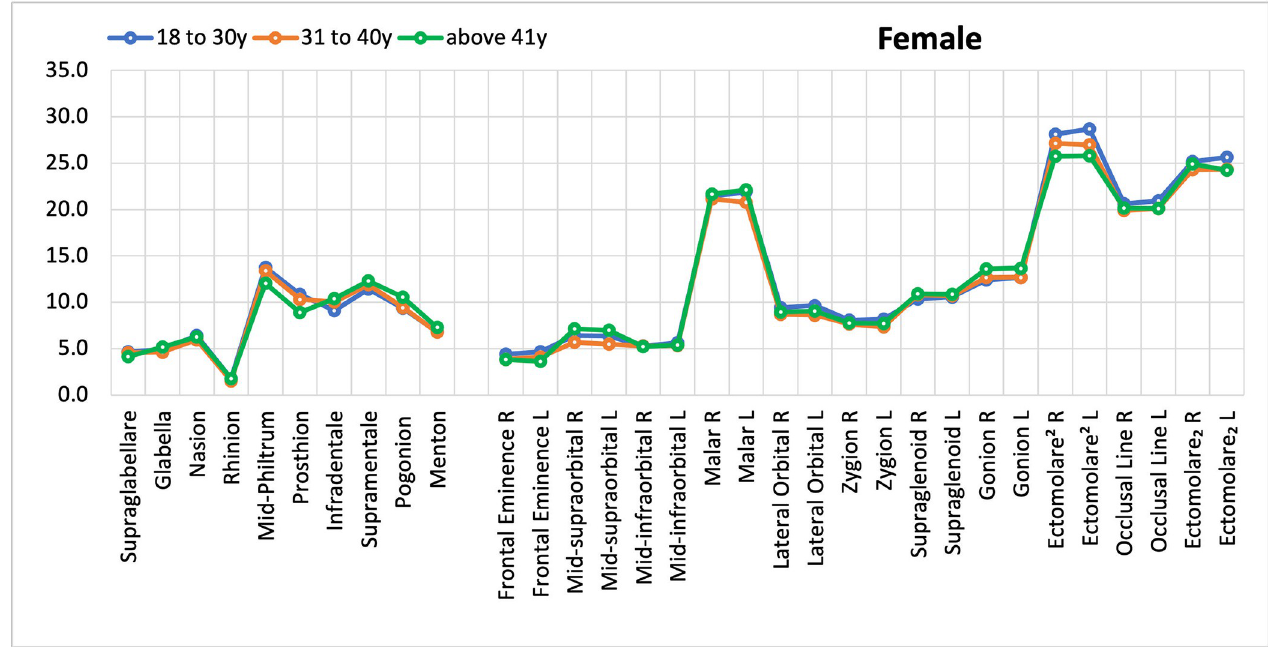
Fig 5. FSTT means: Comparison among age groups in males. https://doi.org/10.1371/journal.pone.0270980.g005 between 10 to 15% in most cases with a few landmarks showing higher values. Within females, studies indicate fewer divergent landmarks (three on the midline and eight bilateral) where only malar showed a difference above 2.5 mm (3.0 mm). These results reveal high